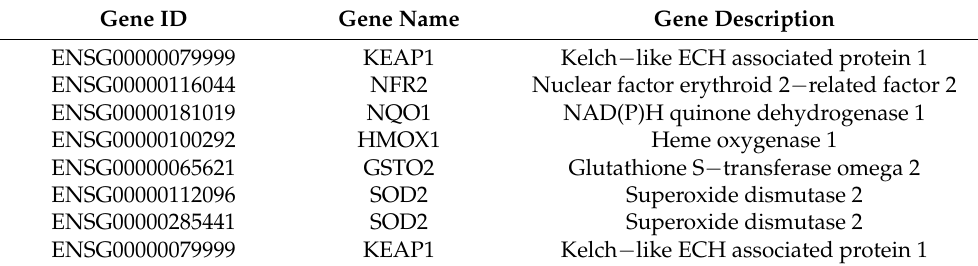
Table A2. Differentially expressed genes associated with NRF2 oxidative stress pathway.